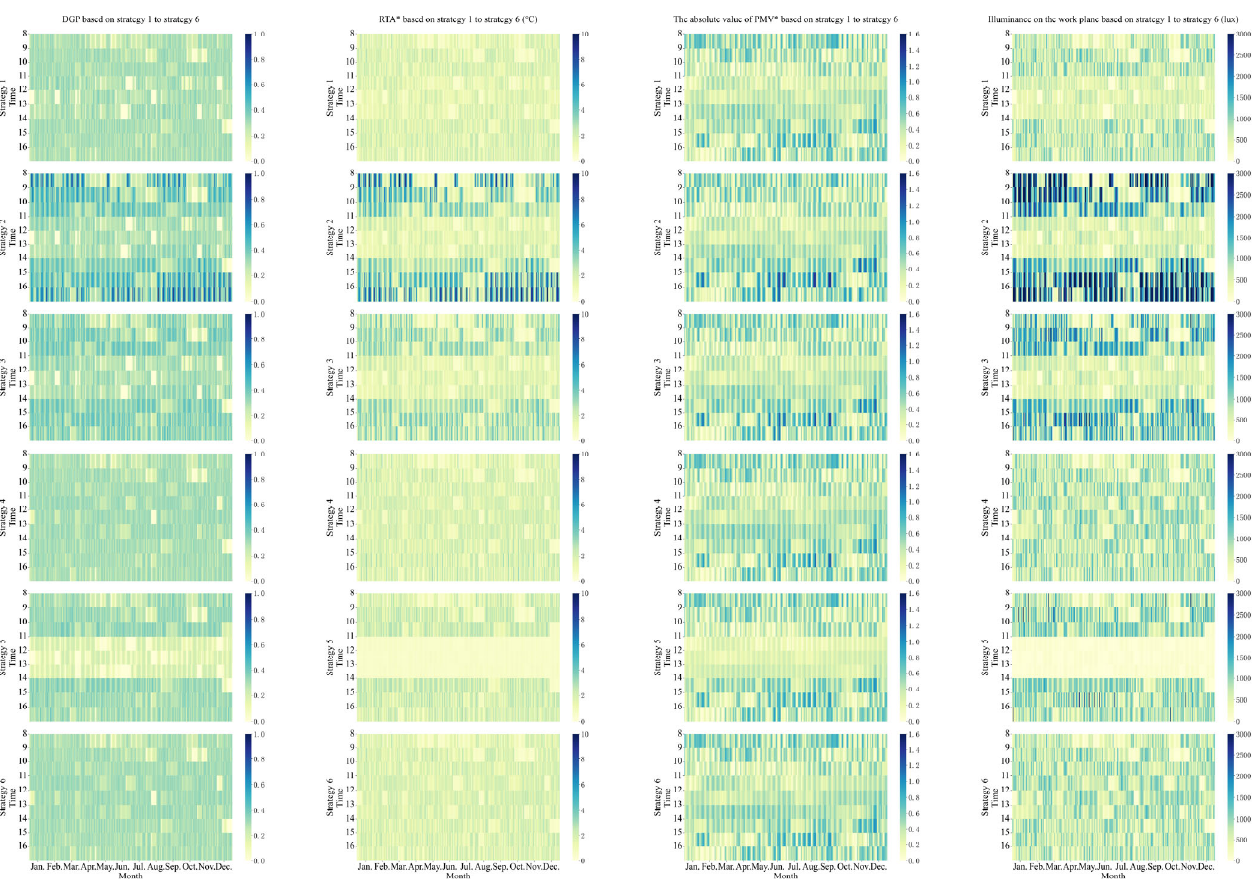
Figure 11. Heat map of annual variation of indices in case 1.